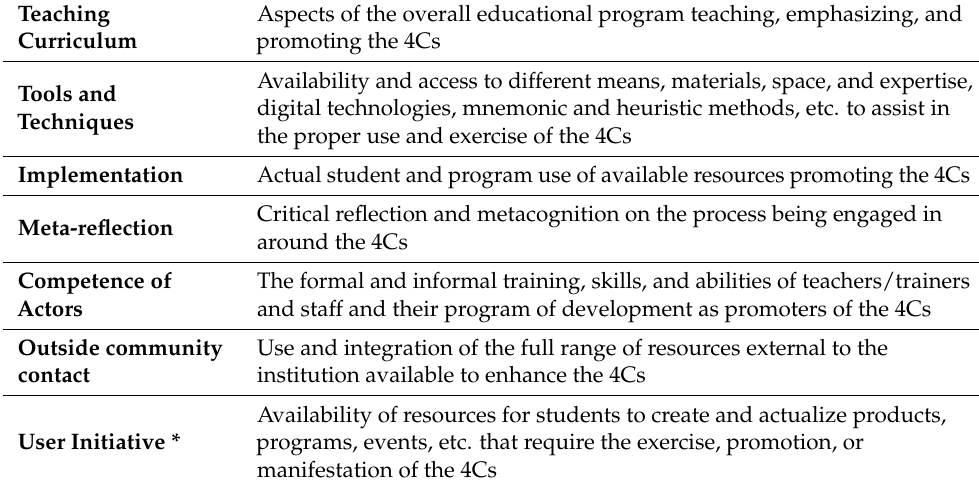
Table 2. Seven dimensions evaluated for the 3 different components of each